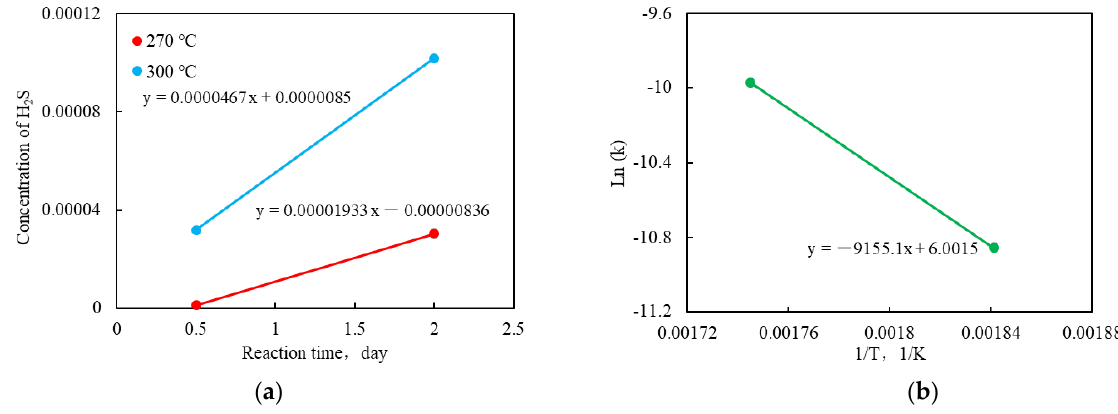
Figure 3. ( a ) Interpolation lines for obtaining the reaction rates at different temperatures; ( b ) An interpolation line for obtaining the kinetic parameters.